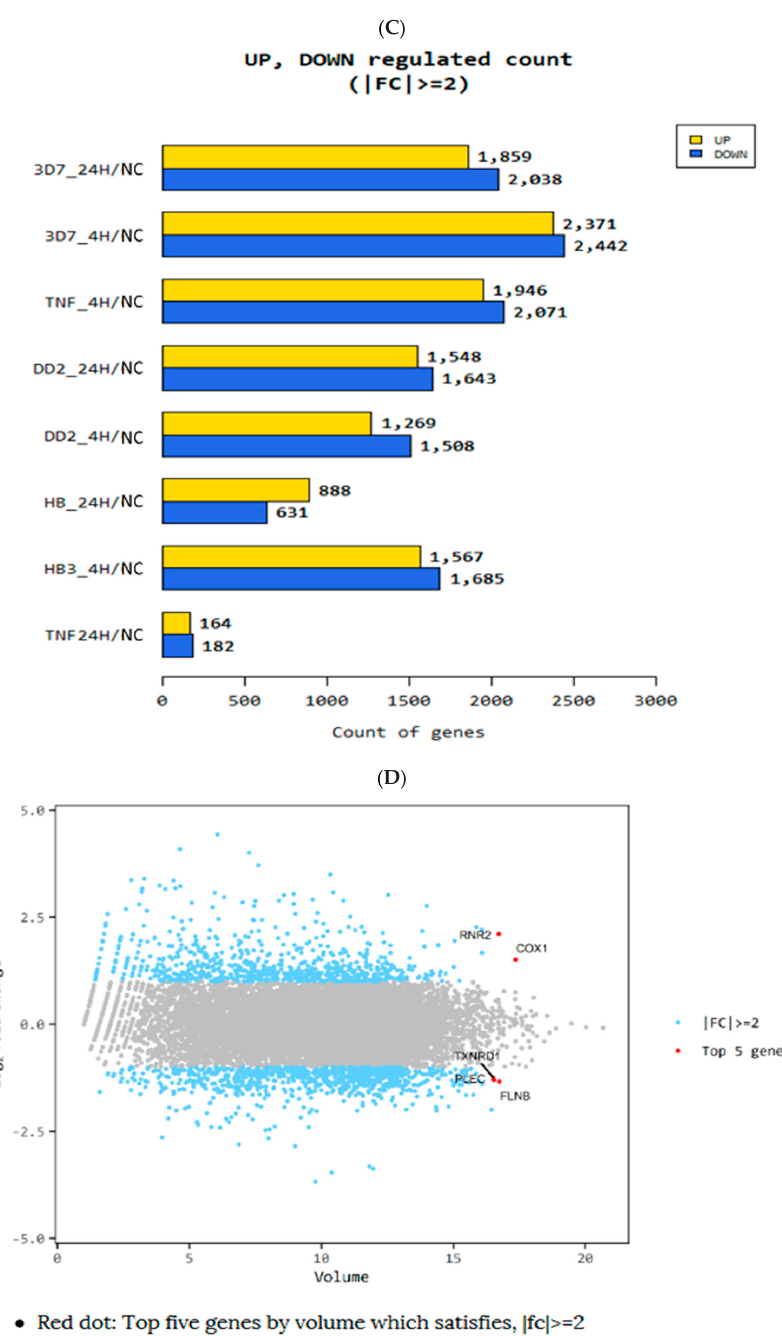
Figure 1. Data quality and data analysis description of HBMEC transcriptome. ( A ) Multidimensional Scaling Analysis: Using each sample’s normalized value, a 2D plot illustrates the variability of the total data. ( B ) Heatmap for DEG-Hierarchical Clustering: The similarity of genes and samples by expression level using Z-score for normalized value (log2 based) are clustered. Up to 3000 of 8055 genes from the significant list satisfied the |fc| ≥ 2. Each column represents a condition. Genes that were down-regulated are shown in blue, and up-regulated in yellow. ( C ) Significant UP and DOWN count by fold change shows up-regulated and down-regulated genes based on fold change of comparison pair. ( D ) Volume Plot between pooled samples for sample versus negative control (NC). Expression volume is the geometric mean of two groups’ expression levels. A volume plot is drawn to confirm the genes that show higher expression differences compared to the control according to the expression volume ( X -axis: Volume, Y -axis: log2 Fold